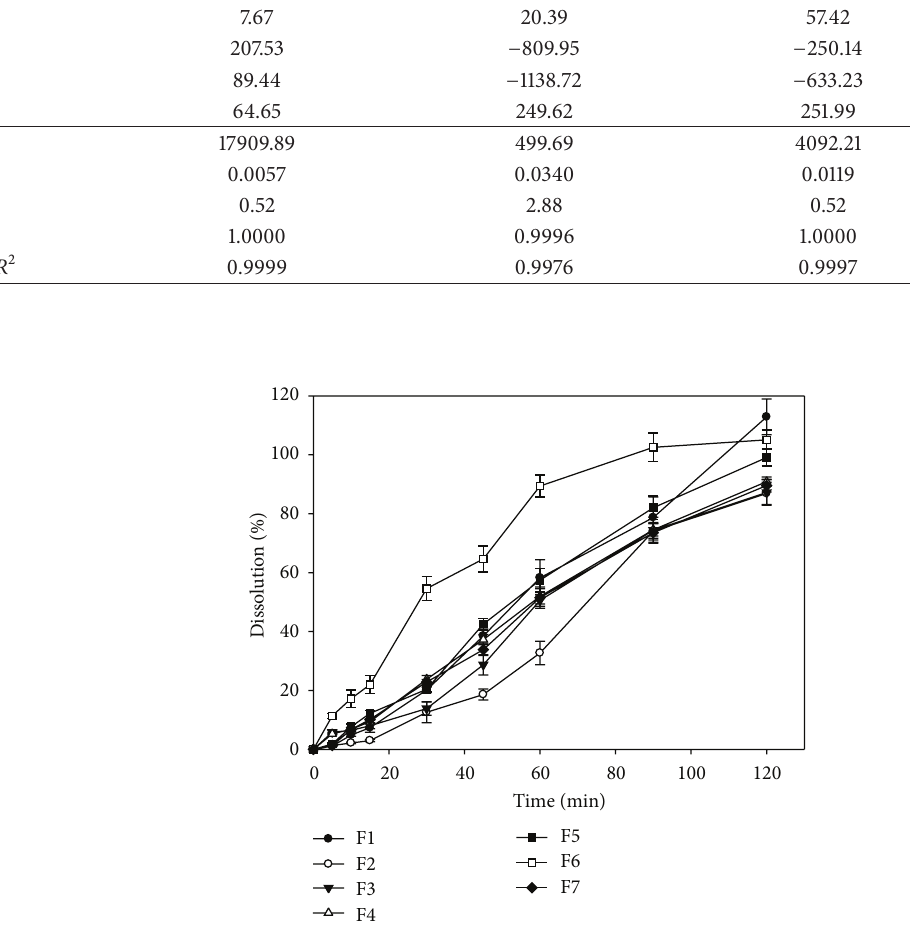
Figure 1: Dissolution profiles of isotretinoin oil-based